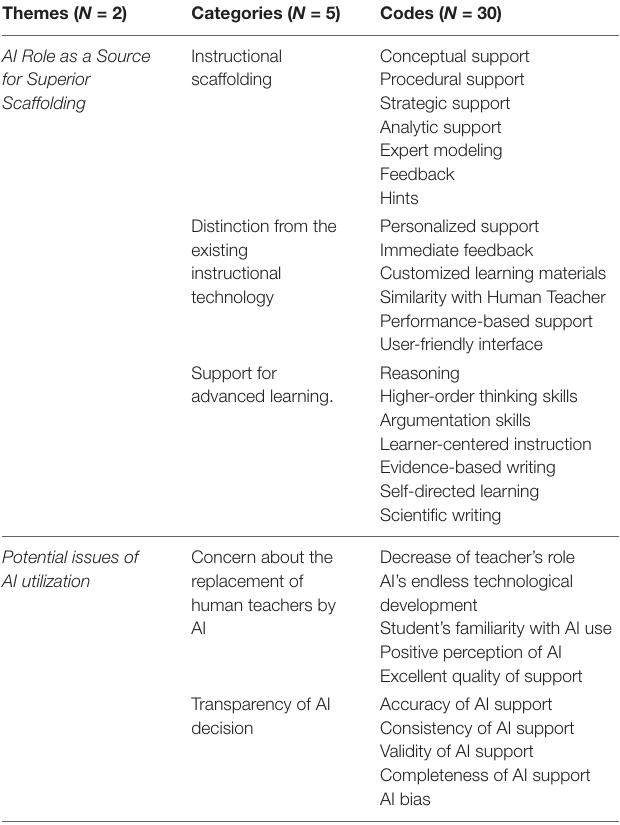
TABLE 3 | Themes and codes identified in